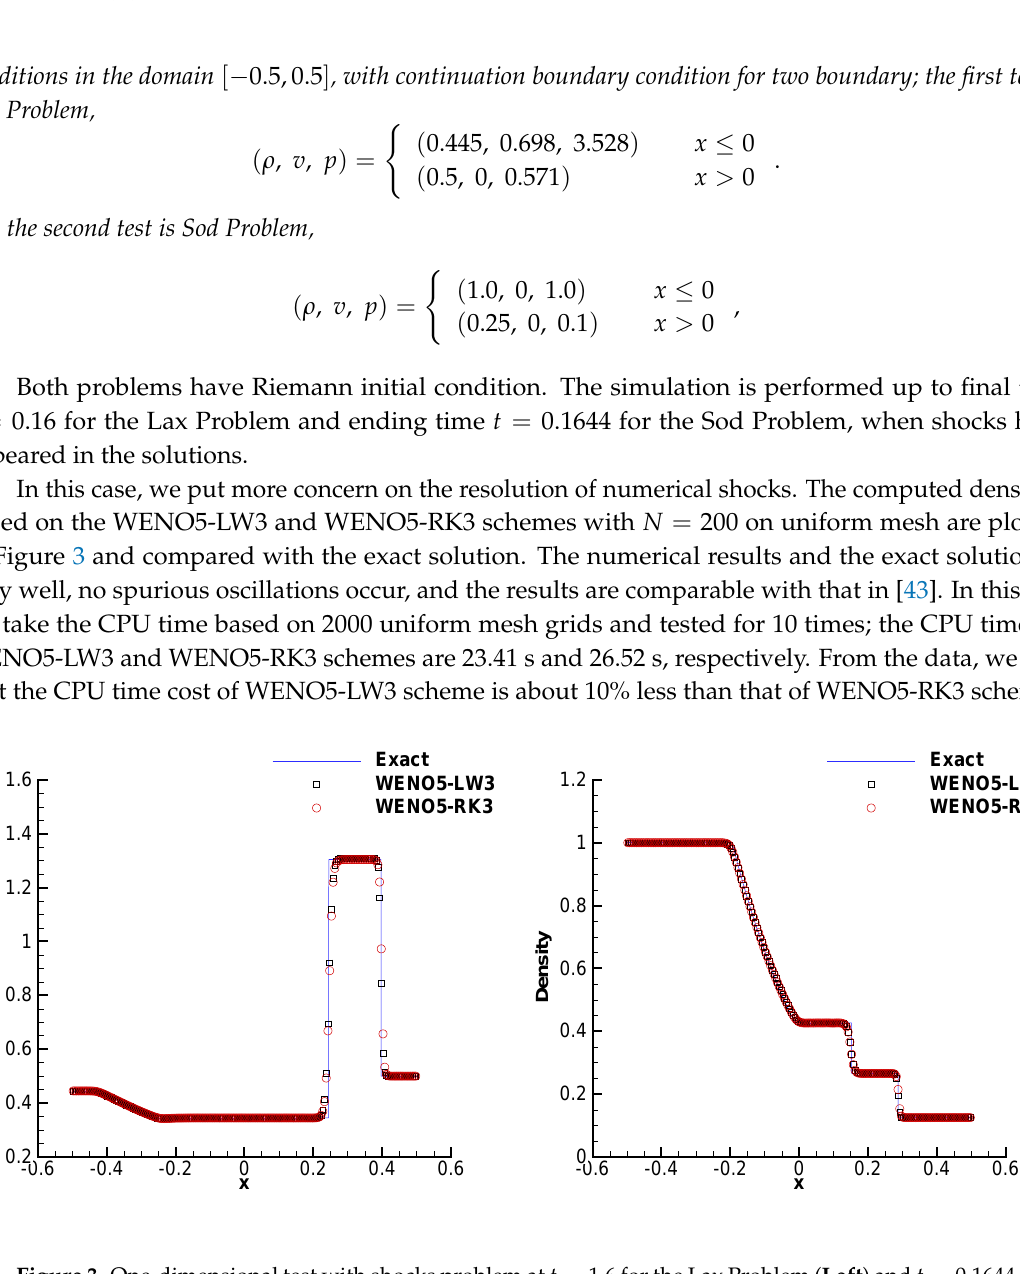
Figure 3. One-dimensional test with shocks problem at t = 1.6 for the Lax Problem ( Left ) and t = 0.1644 ( Right ) for the Sod Problem by WENO5-LW3 and WENO5-RK3 against exact